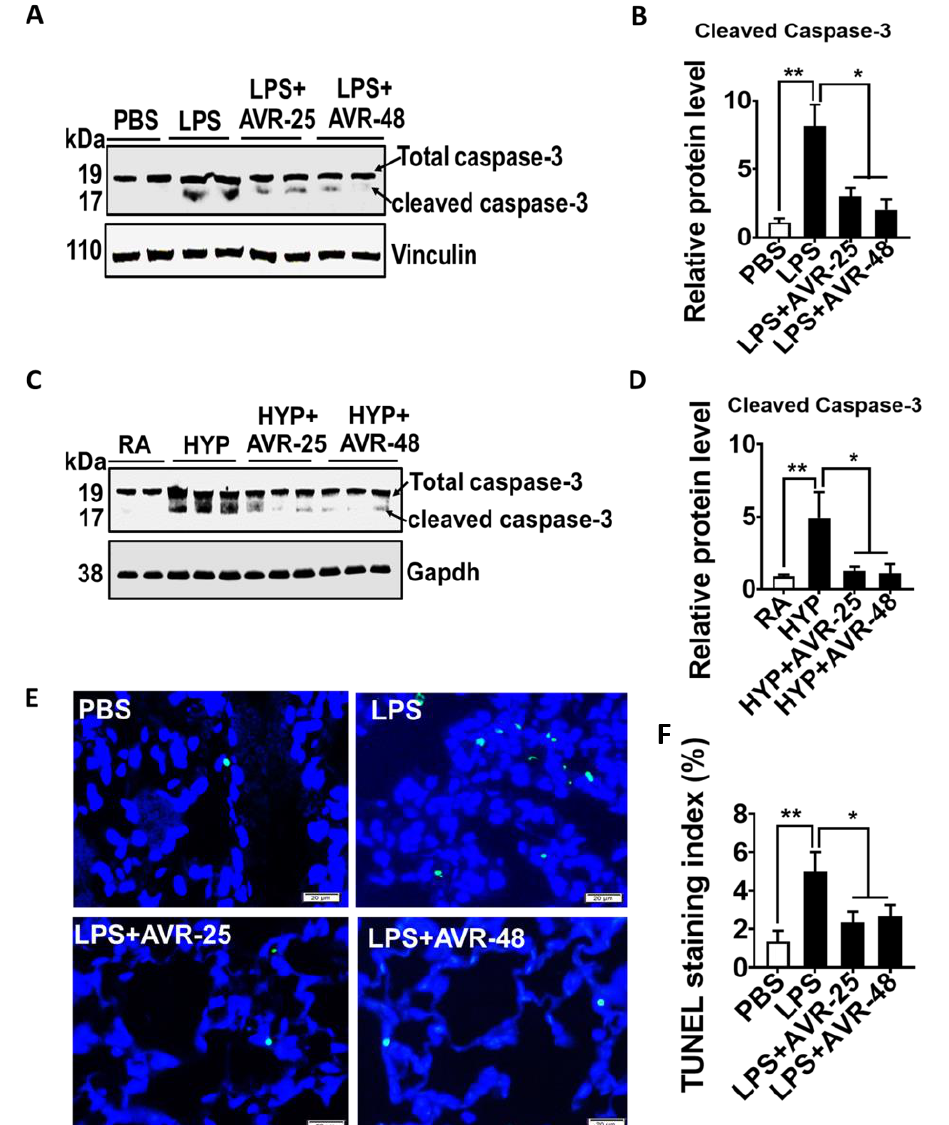
Figure 5. AVR-25 or AVR-48 treatment attenuates lung cell death in LPS- and hyperoxia-induced ALI mice. ( A – D ) Western blot analysis for cleaved caspase-3 in lungs of LPS and hyperoxia-induced lung injury in mice treated with or without AVR-25 or AVR-48. Densitometric quantification of the immunoblots is shown right to immunoblots ( n = 4–6, * p < 0.05 and ** p < 0.01). ( E , F ) Representative figure of TUNEL staining (green color) of apoptotic cells and quantification of apoptotic cells in lungs of LPS and hyperoxia-induced lung injury in mice treated with or without AVR-25 or AVR-48 (* p ≤ 0.05). Scale bar = 20 µ m. Data are expressed as mean ± SEM. For statistical analysis, student’s unpaired t -test and one-way analysis of variance (ANOVA) followed by Tukey post hoc analysis were used. LPS: lipopolysaccharide; ALI: acute lung injury; PBS: phosphate buffered saline; RA: room air; HYP: